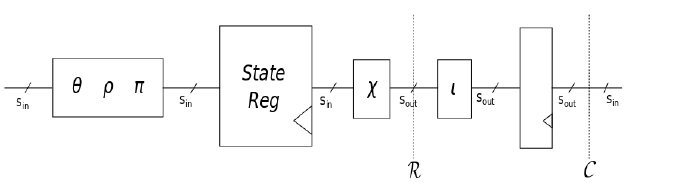
Figure 4: One round structure of NC- Keccak , with the state register after the linear permutations and ι before the second layer of